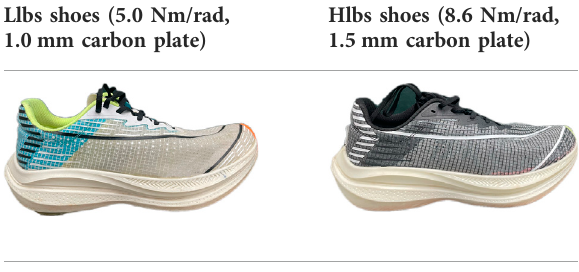
TABLE 1 List of experimental running